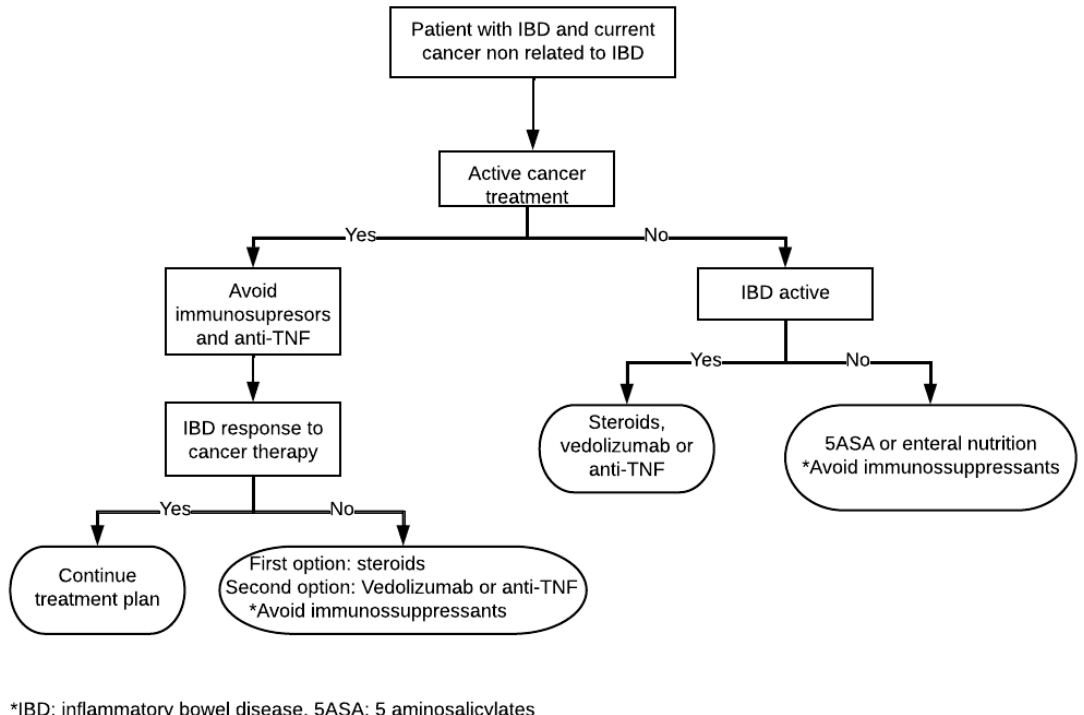
Figure 1. Practical management of patient with IBD and a current diagnosis of cancer.